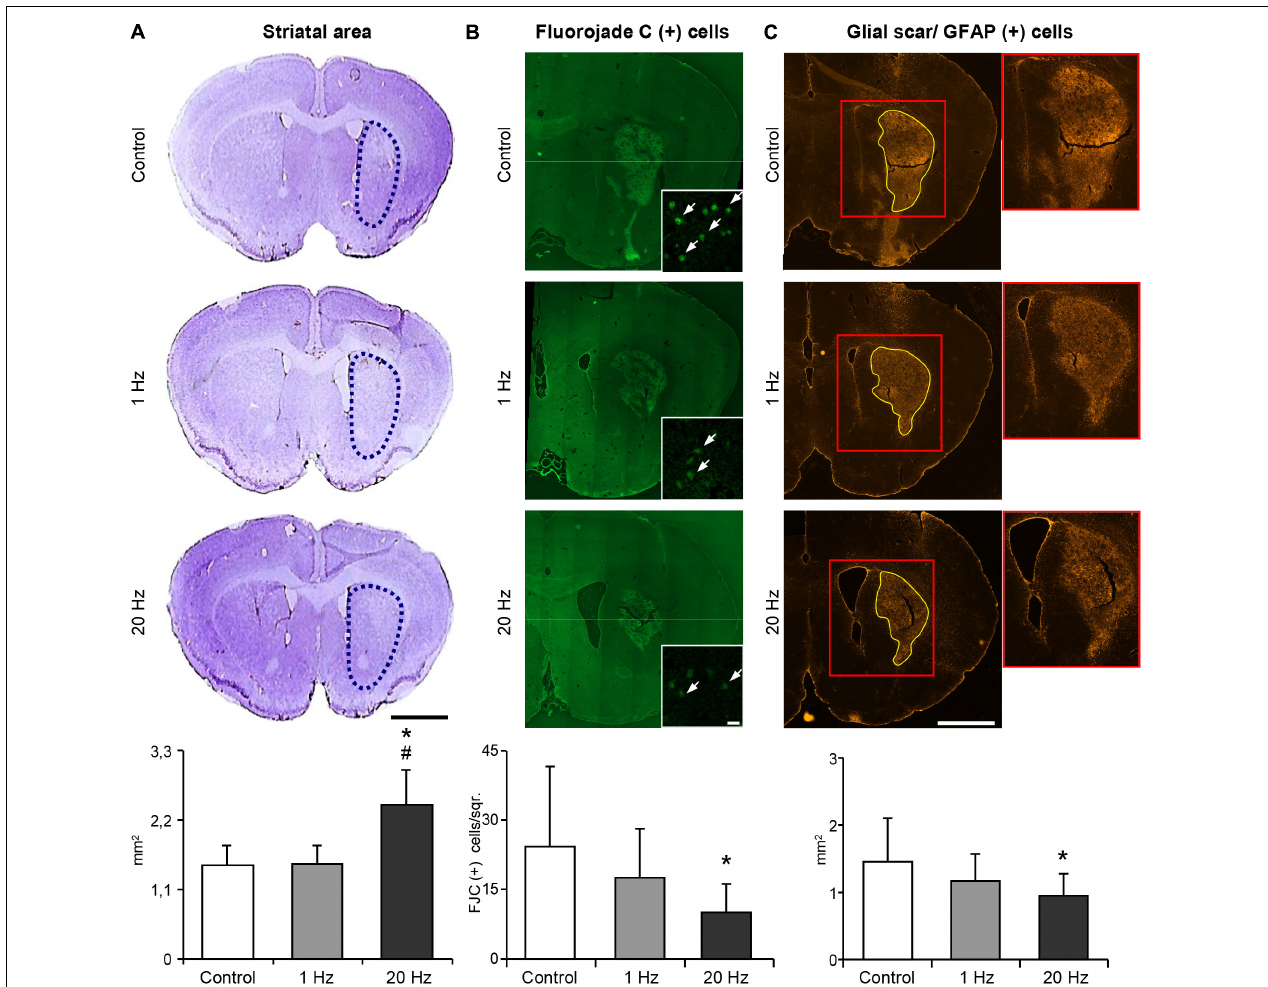
FIGURE 6 | 20 Hz rTMS inhibits delayed neuronal loss and reduces glial scar formation. Striatal atrophy was assessed by cresyl violet staining in the ischemic striatum of animals subjected to 30 min ischemia followed by 42 days reperfusion (A) . Dotted black lines indicate the area of ischemic striatum in cresyl violet stained sections. Quantification of striatal area is given in the graphs below. Significantly increased striatal area indicates that 20 Hz rTMS significantly decreased striatal atrophy. Degenerating cells were counted using Fluorojade C stained brain sections (B) . 20 Hz rTMS-applied animals displayed significantly decreased number of Fluorojade C (+) cells. White arrows indicate Fluorojade C (+) cells. Glial scar area was measured in GFAP-stained sections in animals subjected to 30 min ischemia followed by 42 days reperfusion (C) and high-frequency rTMS resulted in the significantly decreased glial scar area when compared with control. Data were evaluated by one-way ANOVA followed by LSD tests. Data are presented as mean ± SD values ( n = 7–8 mice/group). ∗ p < 0.05 compared with control group and # p < 0.05 compared with 1 Hz rTMS. Scale bar is 2 mm (A,C) 50 µ m (B)